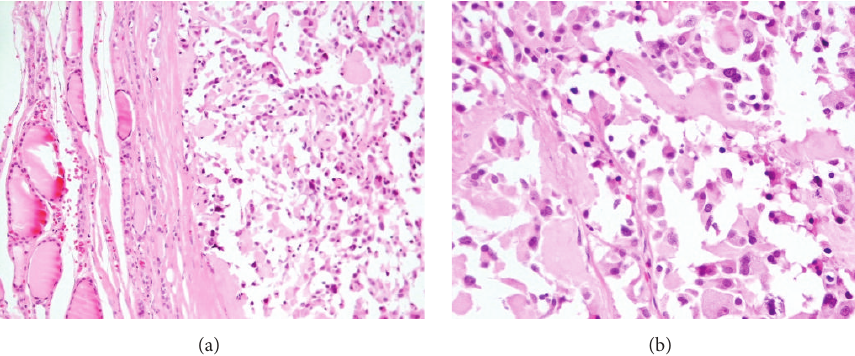
Figure 1: Medullary carcinoma (H + E): nests or chords of cells penetrating dense pink stroma ((a) × 200). Tumor cells were round, relatively uniform with a punctuate chromatin ((b) × 400).